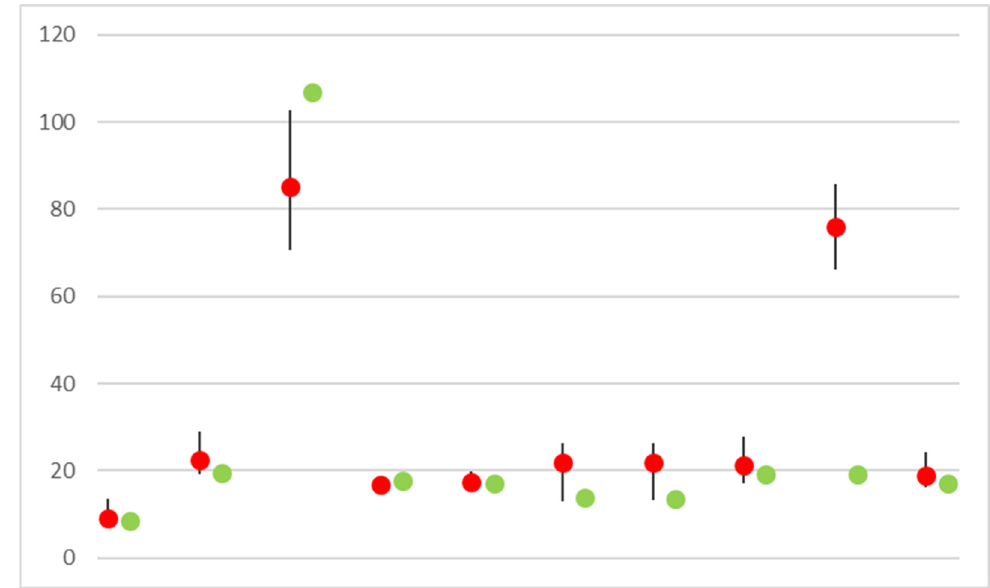
Figure 2. Concentration of nitrogen dioxide (in µg/m 3 ) in the classrooms (minimum—arithmetic mean—maximum, in red) and in front of the school (one sampling point per school, in green). The urban values in particular are high compared to the results of various studies [31] from the same region. For example, NO 2 in Serbia was between 12 and 22 µ g/m 3 . If the outdoor values are viewed as representative for a whole year, they exceeded the annual limit value of 40 µ g/m 3 according to European legislation in several places